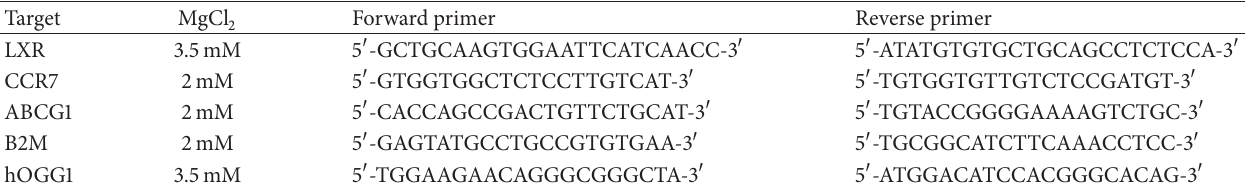
Table 1: Primers used in real-time qPCR